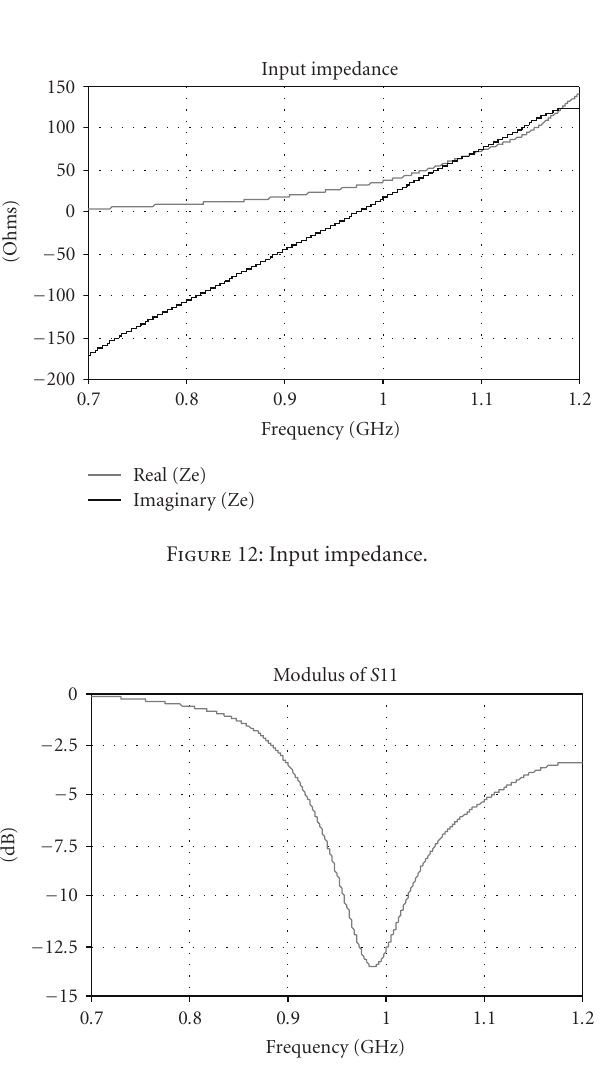
Figure 13: Antenna matching ( | S 11 | ).